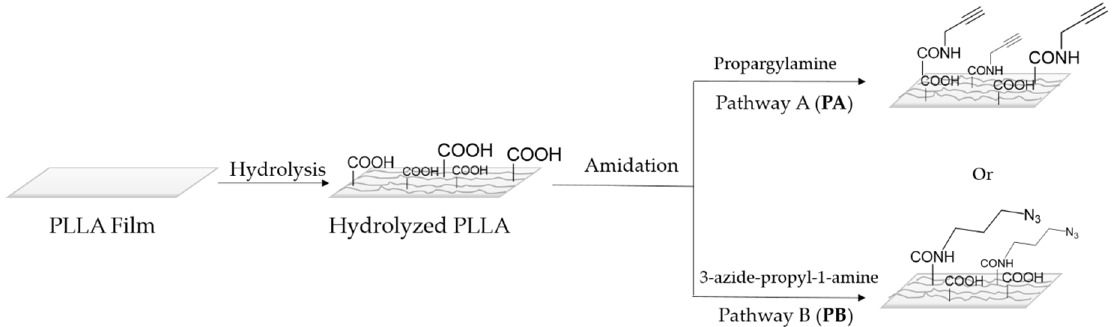
Scheme 1. Representative scheme of hydrolysis and amidation reactions onto PLLA film through two different pathways.